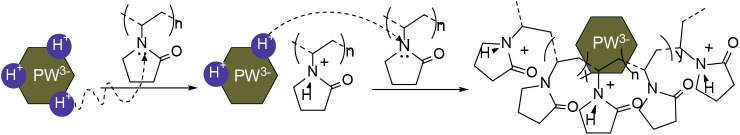
Synthetic routes to PVP-HPAs model.